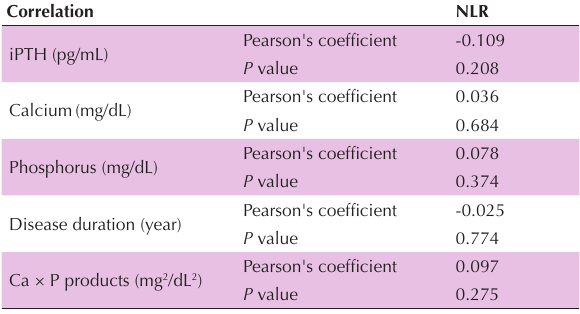
Table 3. Pearson’s correlation between NLR and other effective factors